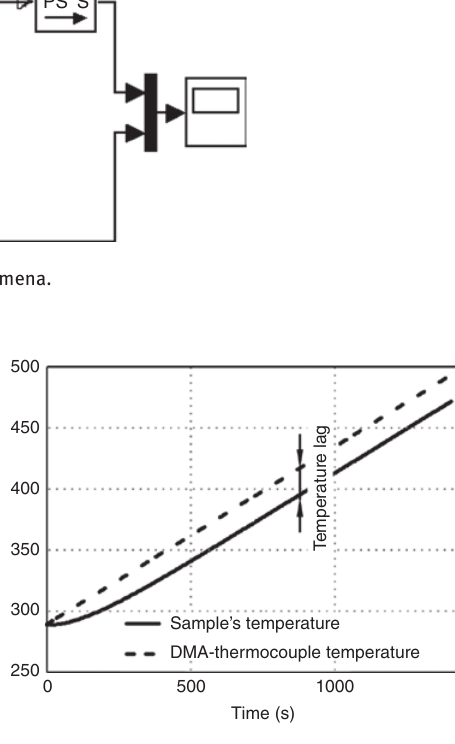
Figure 2: Exemplary results for temperature lag occurring from convection phenomena for the GFRP specimen with the heating rate of 8